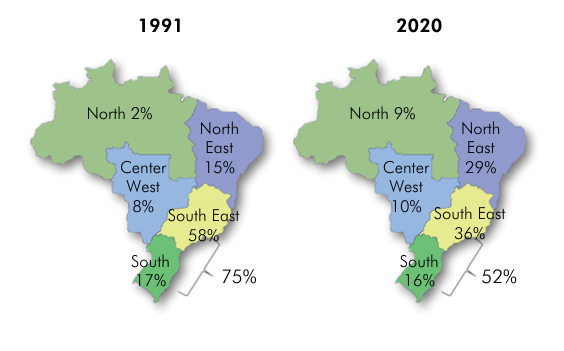
Figure 3. Distribution of Dentistry courses per Brazilian geographic region in 1991 (n = 82) and 2020 (n = 544), obtained from e-MEC 2 and CES.